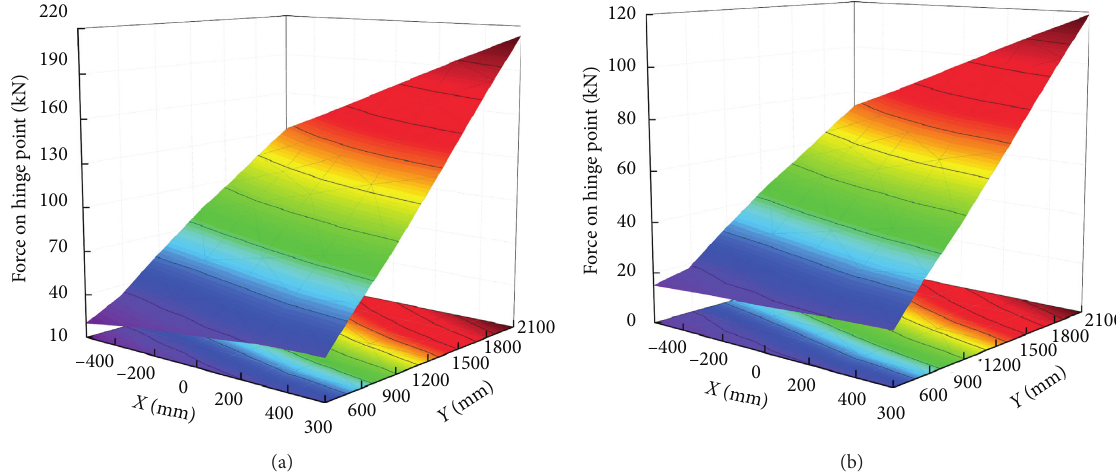
Figure 18: Load-bearing characteristics of the four-bar linkage with integral face guard. (a) Hinge joint of connecting rod A and face guard. (b) Hinge joint of connecting rod A and connecting rod B